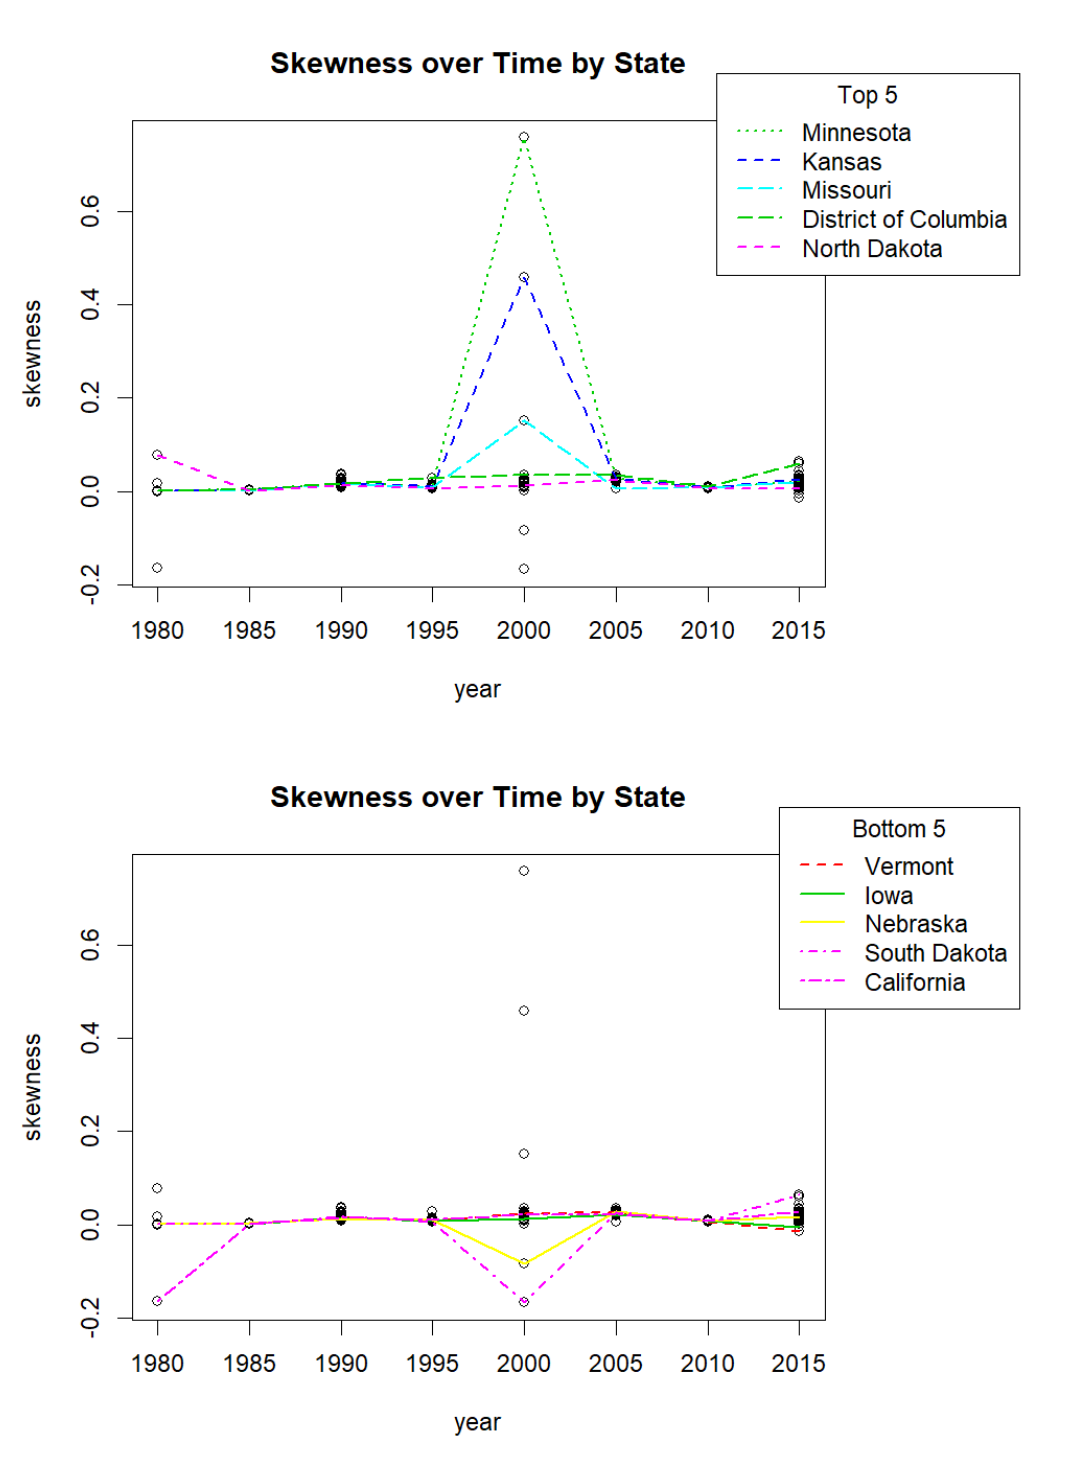
Figure 6. Skewness top 5 and bottom